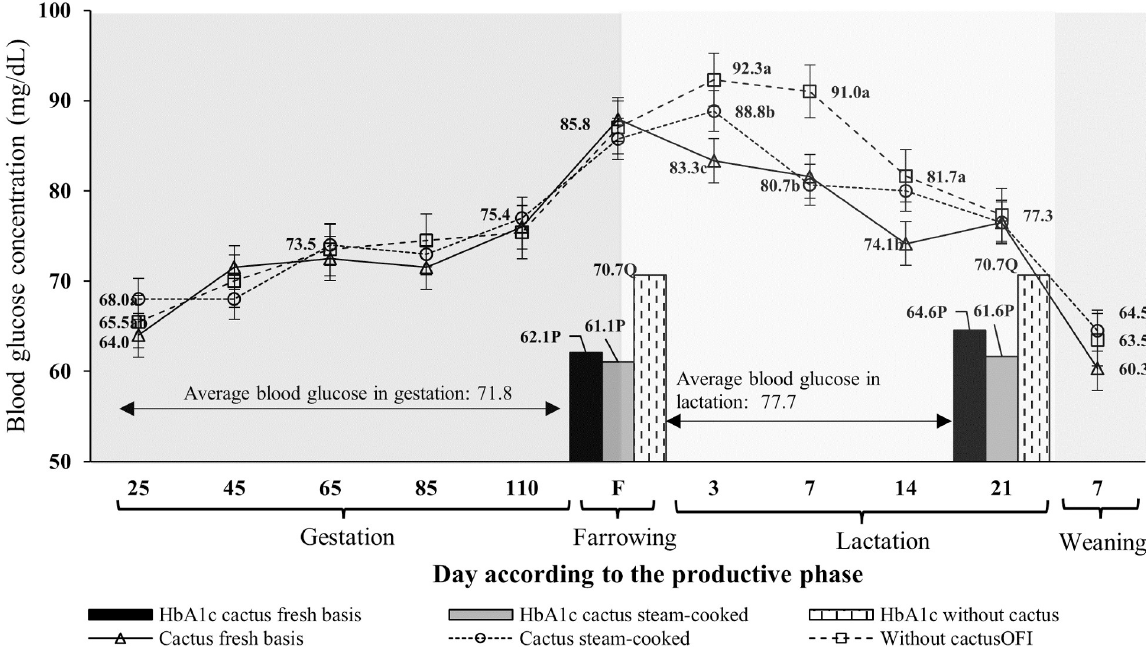
Fig 2. Dynamics of preprandial blood glucose of sows during the gestation to weaning phases and HbA1c on the farrowing day and weaning day, with cactus intake during lactation. Each point or bar represents the mean ± standard error of mean (SEM; n = 12